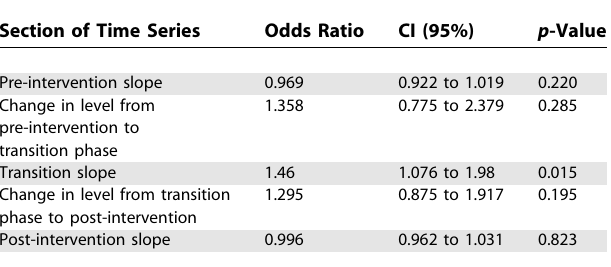
Table 3. Regression Analysis for Main Outcome (Prescribing of